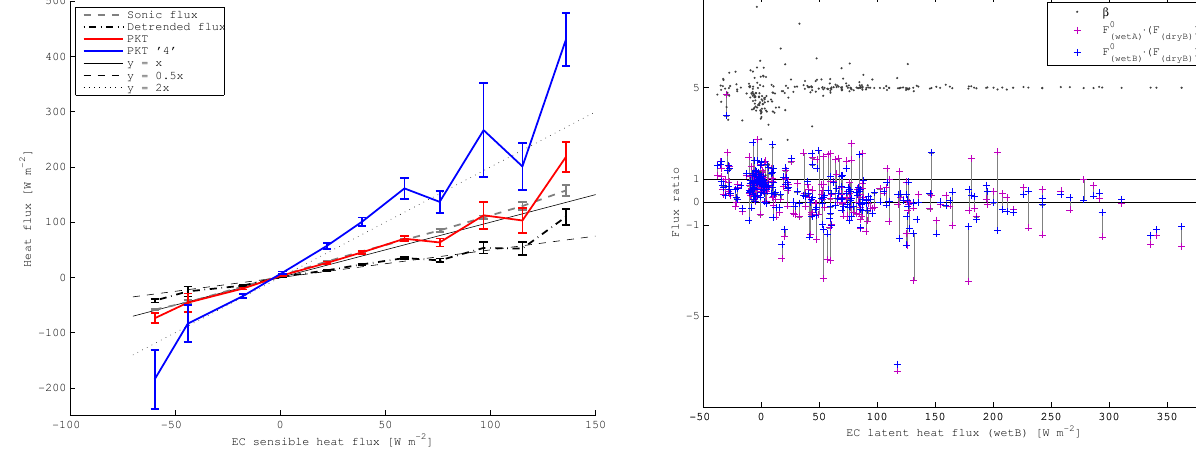
(cid:16) (cid:17) − 1 h RH 0 w 0 i ∂ h x v i 1 − 0 . 5 h x 0 0 i ∂ h RH i v w